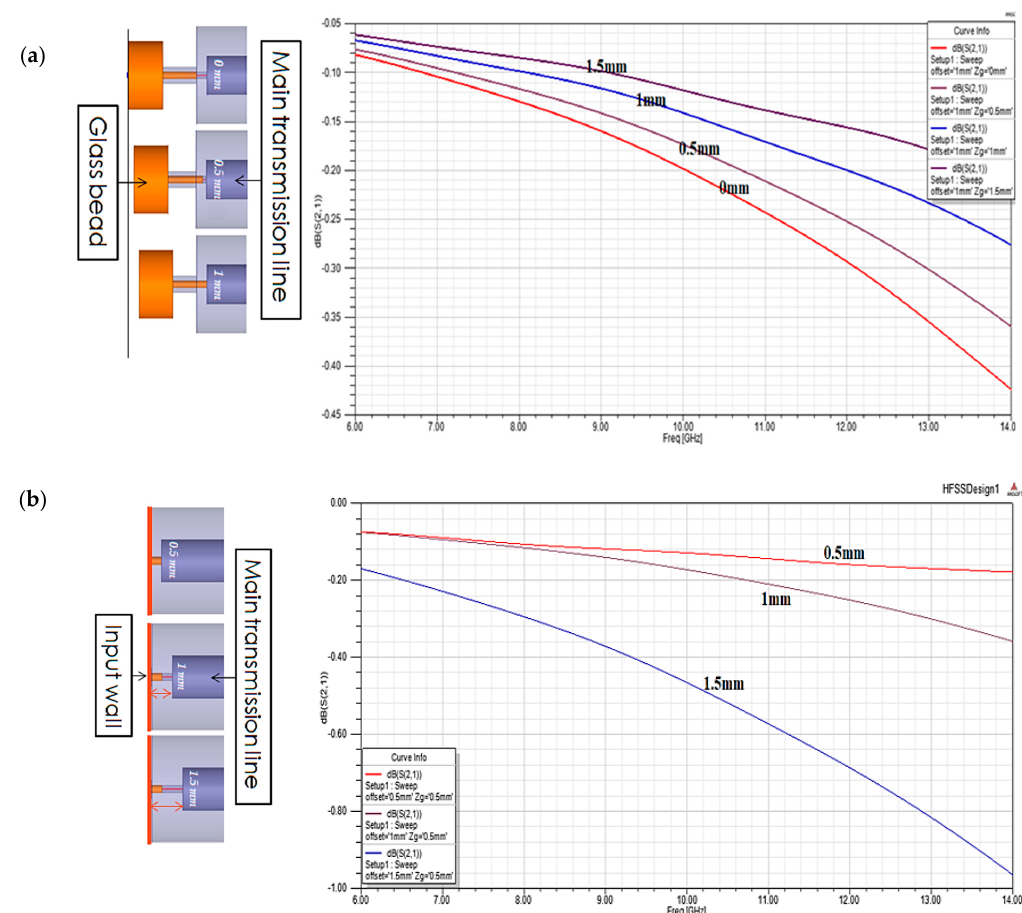
Figure 16. Transmission coefficient for different insertion lengths of the glass bead ( a ) and different distances of the main transmission line from the input / output port ( b ).